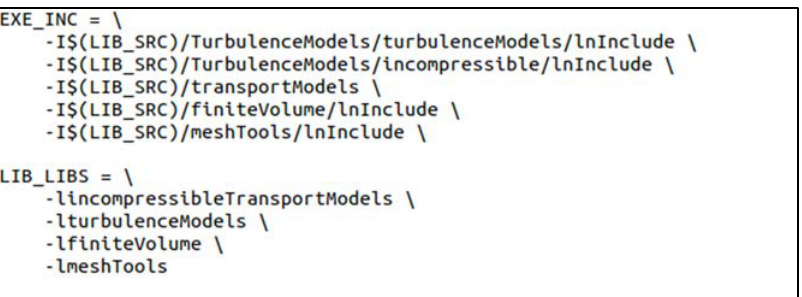
Figure 3. The options source code.